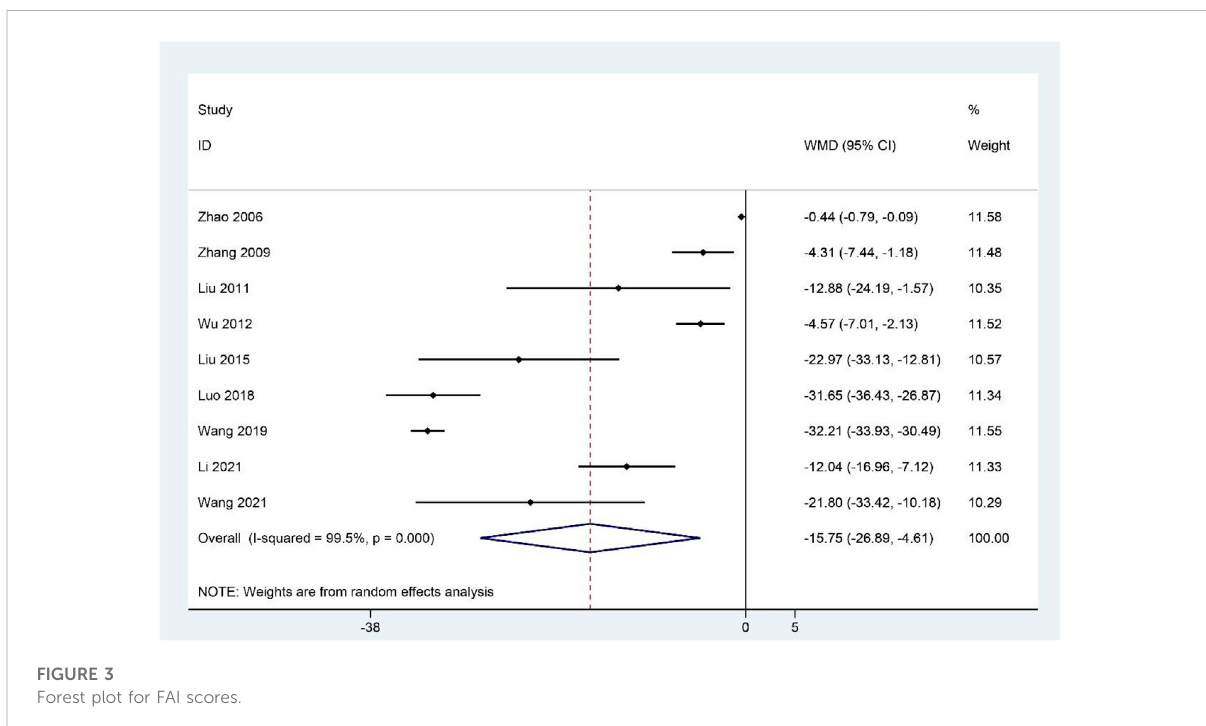
FIGURE 3 Forest plot for FAI scores.